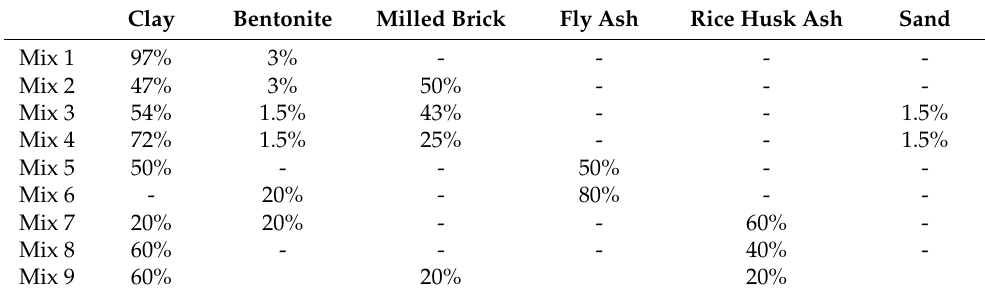
Table 10. Mix ratio of the different materials for mineral sealing layer used in the comparative study. Clay Bentonite Milled Brick Fly Ash Rice Husk